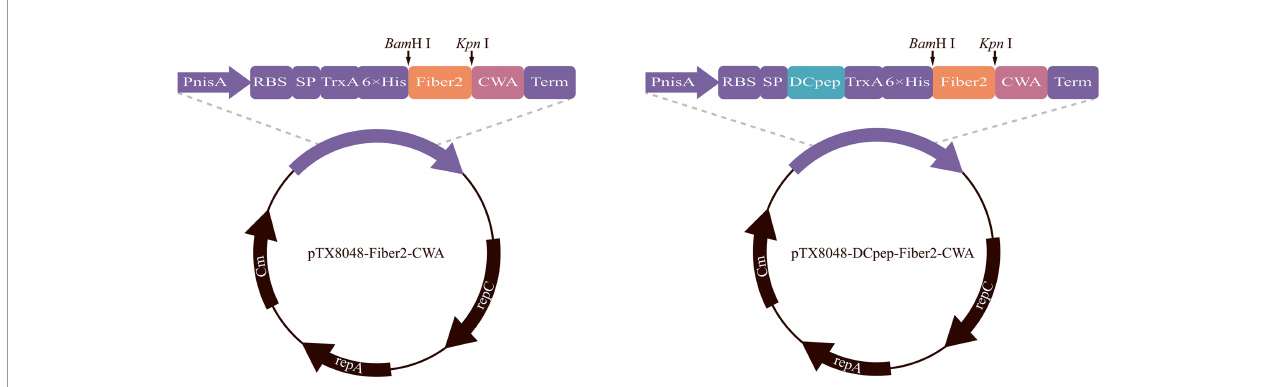
FIGURE 1 | Plasmid schematic of pTX8048-Fiber2-CWA and pTX8048-DCpep-Fiber2-CWA. Both plasmids contain the nisin-inducible promoter and CWA (cell wall anchor) that was fused to the C-terminal of Fiber2 protein. Plasmids pTX8048-DCpep-Fiber2-CWA contained a fused dendritic cell targeting peptide (DCpep) at the N-terminal of